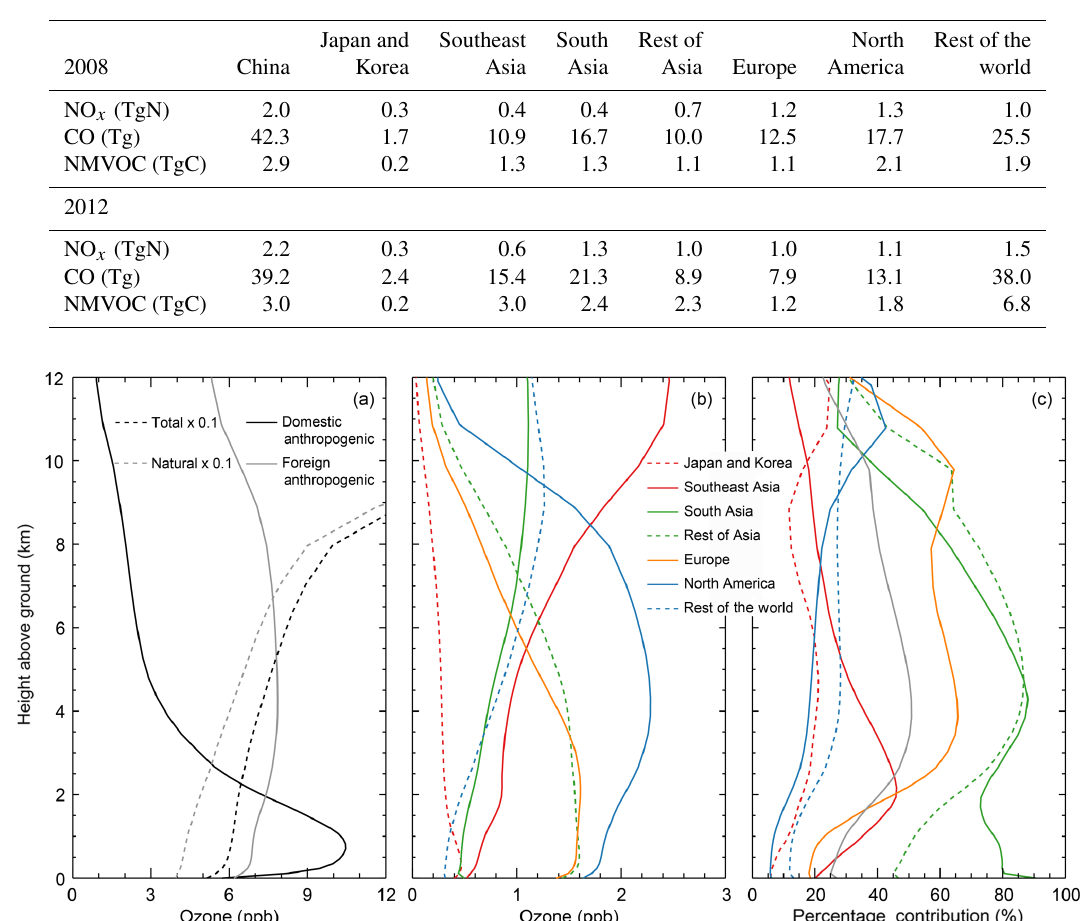
Figure 13. (a) Vertical distribution of China average daily mean ozone contributed by domestic anthropogenic emissions, foreign anthro- pogenic emissions, natural sources (scaled by 0.1), and total sources (scaled by 0.1). (b) Contribution by anthropogenic emissions of each foreign source region. (c) Of the ozone over China due to anthropogenic emissions of each foreign region, the portion produced within each foreign source region’s territory was calculated based on a combination of zero-out and tagged simulations. The linear weighting adjustment is applied to derive all